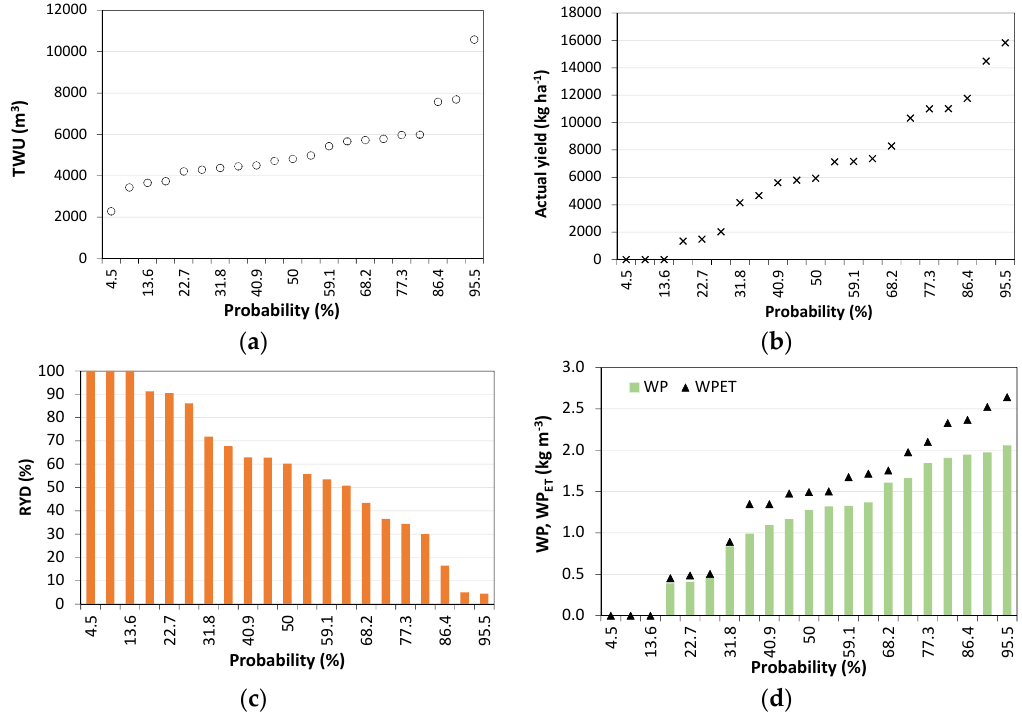
Figure 7. Probability curves characterizing rainfed maize through 22 years data relative to: ( a ) total water use (TWU); ( b ) estimated actual yield; ( c ) relative yield decrease (RYD); and ( d ) total and consumptive use water productivity.